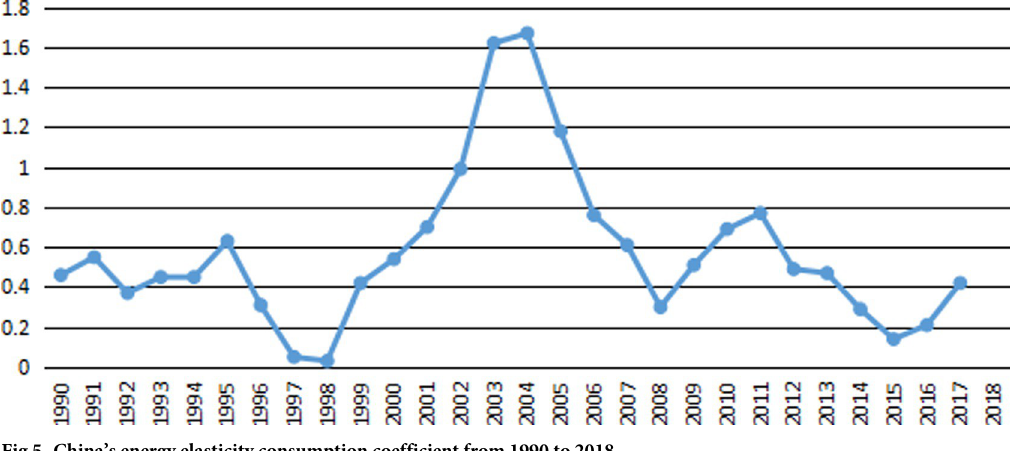
Fig 5. China’s energy elasticity consumption coefficient from 1990 to